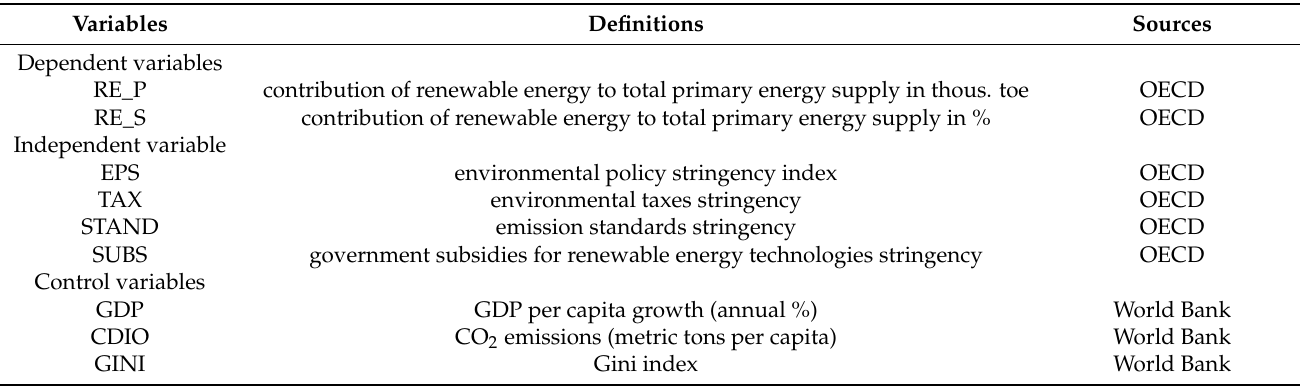
Table 1. Description of variables used in